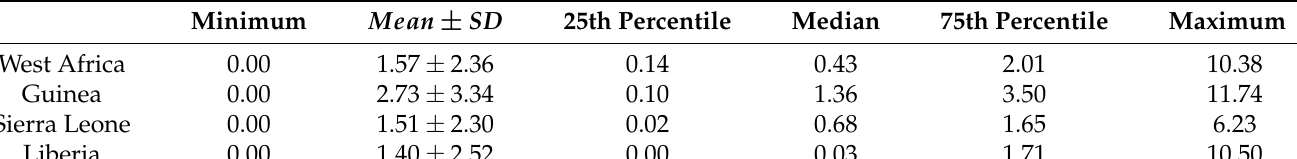
Table 4. Summary statistics of Ebola results for β ( t ) .